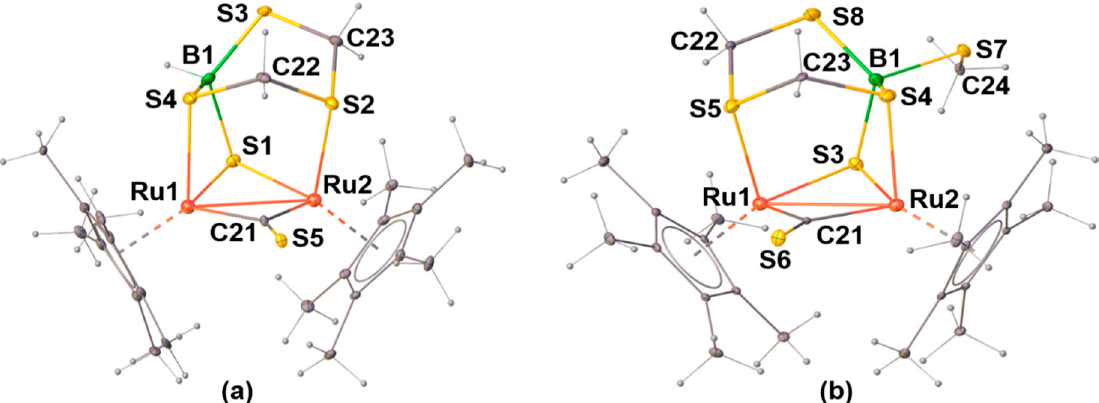
Figure 1. Molecular structures and labelling diagrams of 2 ( a ) and 3 ( b ). Selected bond lengths (Å) and angles (°): 2 : B1–S3 1.885(8), S1–Ru1 2.3436(14), Ru1–Ru2 2.7590(6), C21–S5 1.612(5), C23–S3